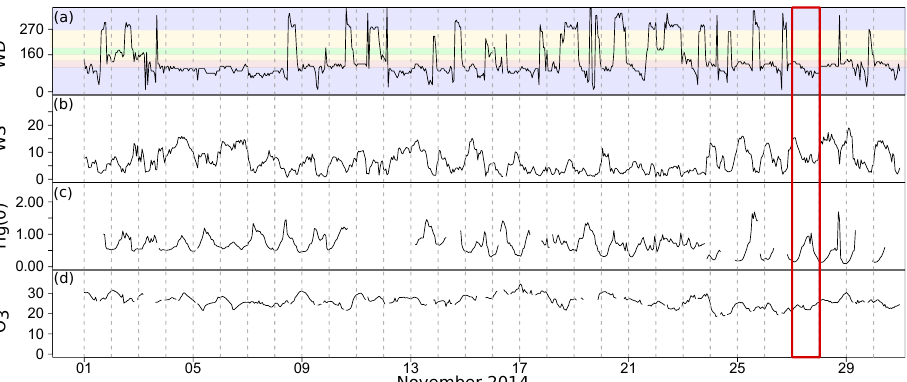
Figure 9. November 2014 variation of (a) wind direction (WD, in ◦ ), (b) wind speed (WS, in ms − 1 ), (c) Hg(0) concentration (in ngm − 3 ), and (d) O 3 mixing ratio (in ppbv). With north at 0 ◦ , oceanic winds ranged from 270 to 110 ◦ (purple), coastal winds from 110 to 130 ◦ (pink), katabatic winds from 160 to 180 ◦ (green), and continental winds from 130 to 160 ◦ and from 180 to 270 ◦ (yellow). On 27 November 2014 (period framed in red), a sea breeze is observed around midday: WD changes from ∼ 120–130 to below 110 ◦ while WS decreases. Both Hg(0) concentrations and O 3 mixing ratios are not higher than during the previous